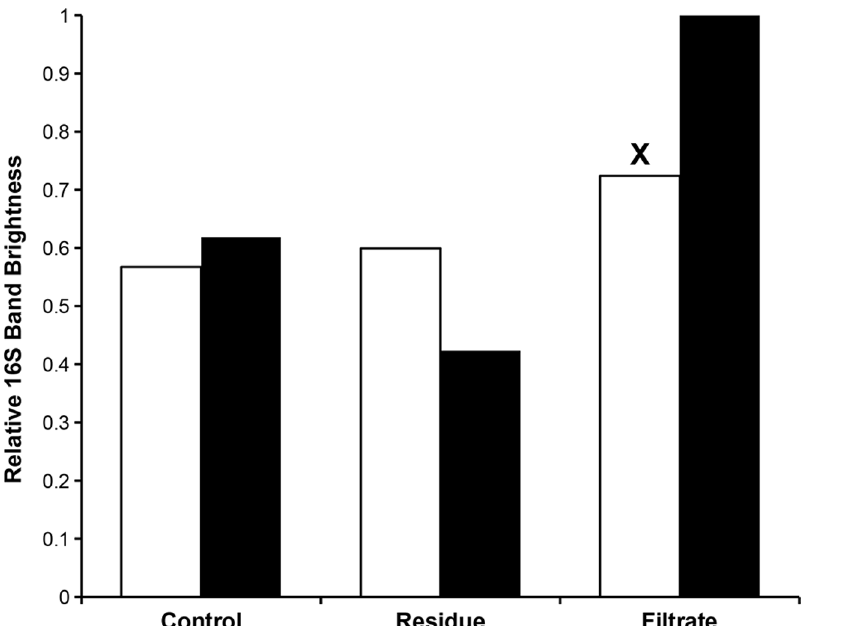
Figure 8. The Effect of Antibiotic and Filtration Treatment on the Relative Bacterial Contents of Choanoflagellate Cultures. White bars are assay results from S. diplocostata , black bars are assay results from D. grandis. For D. grandis the treated residues show a lower bacterial content than the unfiltered and untreated control. For S. diplocostata the treated residue has a slightly higher bacterial content than the control samples. The D. grandis filtrate contains only bacterial signal, whilst for S. diplocostata a relative 18S band brightness of 0.28 is present (X), indicating that choanoflagellates are present in the filtrate.